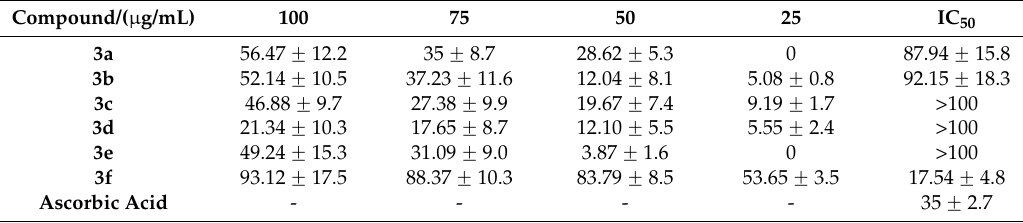
Table 5. ABTS radical scavenging activity of the synthesized compounds measured at 745 nm as compared to standard ascorbic acid. Values are the average of triplicate